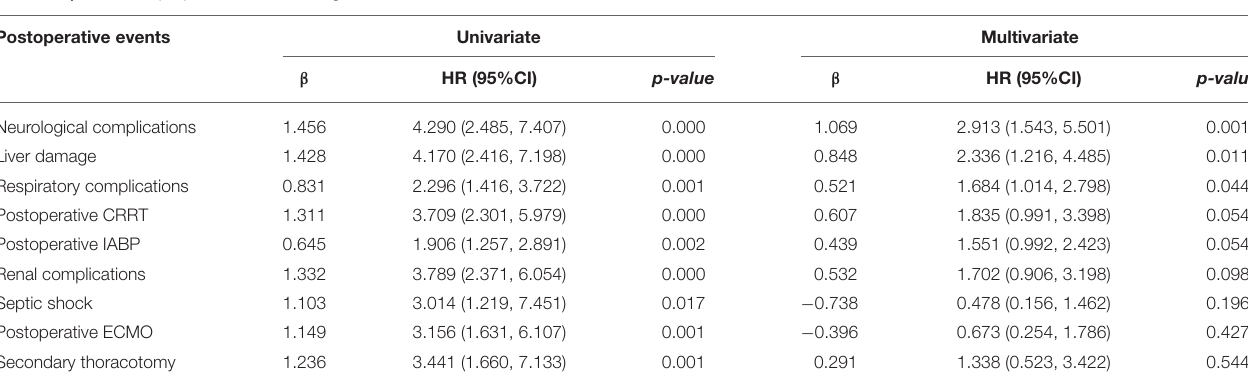
TABLE 3 | Results of proportional hazards regression